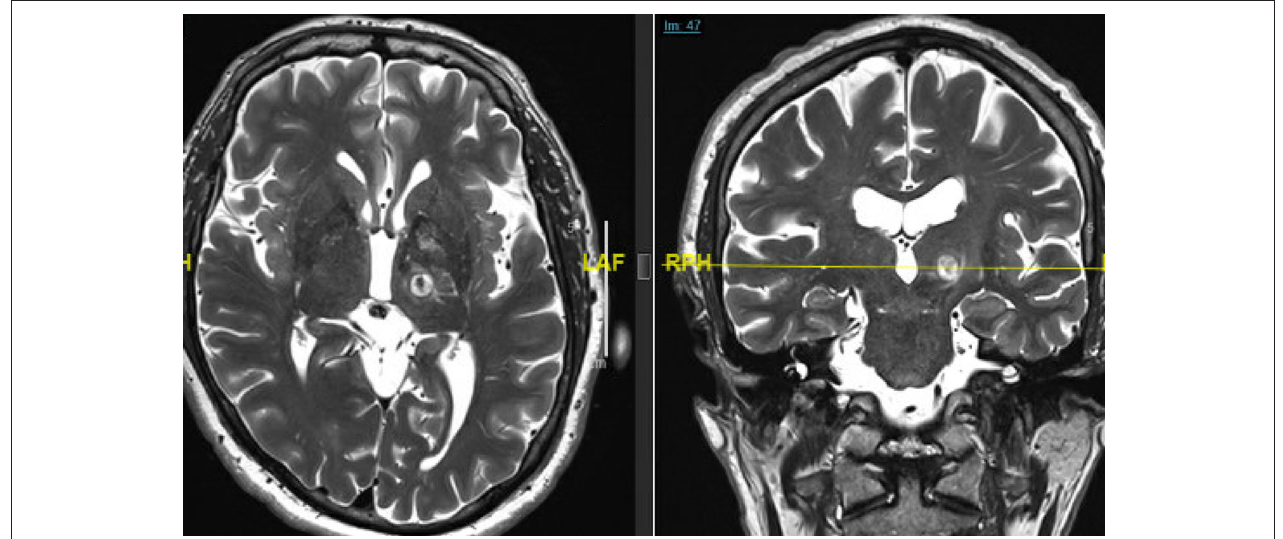
FIGURE 1 | Immediate (24h post-op) T2-weighted axial (left) and coronal (right) MRI scans demonstrating the size, shape, and location of a typical left Vim FUS thalamotomy. Note the edema extending around the lesion into the surrounding thalamus and the internal capsule.